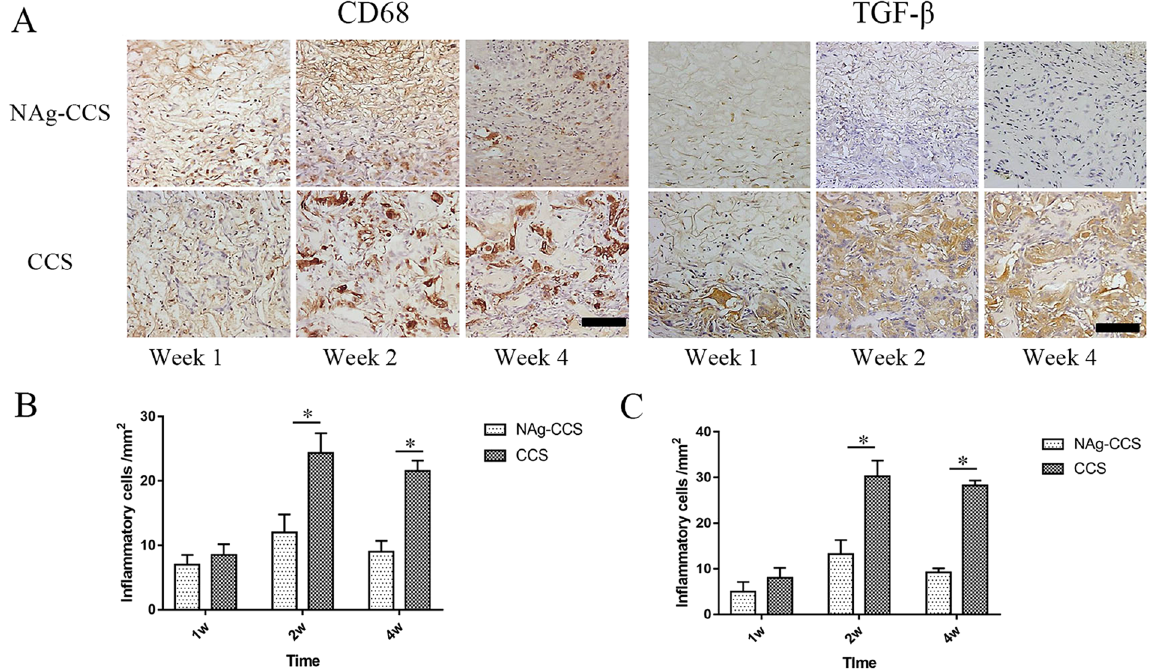
Figure 7. Immunostaining of CD68 and TGF- β of sections of NAg-CCS and CCS at week 1, 2 and 4 post transplantation. ( A ) CD68 and TGF- β immunohistochenmical staining and the relevant counting of inflammatory cell with positive staining of NAg-CCS ( B ) and CCS (C). * Indicates a statistically significant difference, P < 0.05. The bar indicates 50 μ m.